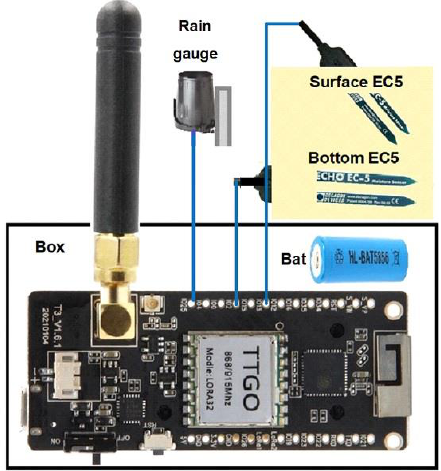
Figure 8. Microcontroller for monitoring soil moisture and rainfall.